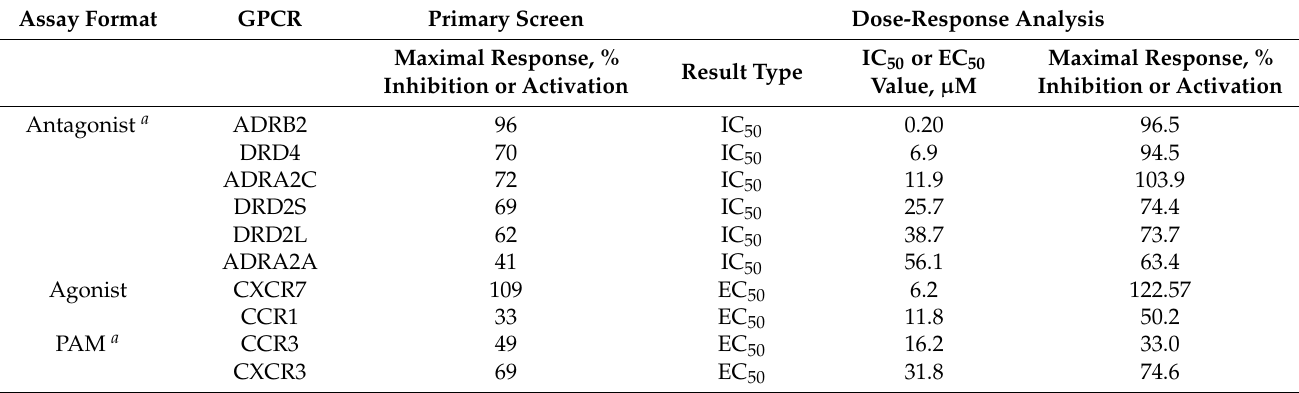
Table 2. Validated aaptamine activity as a positive allosteric modulator (PAM), antagonist, and